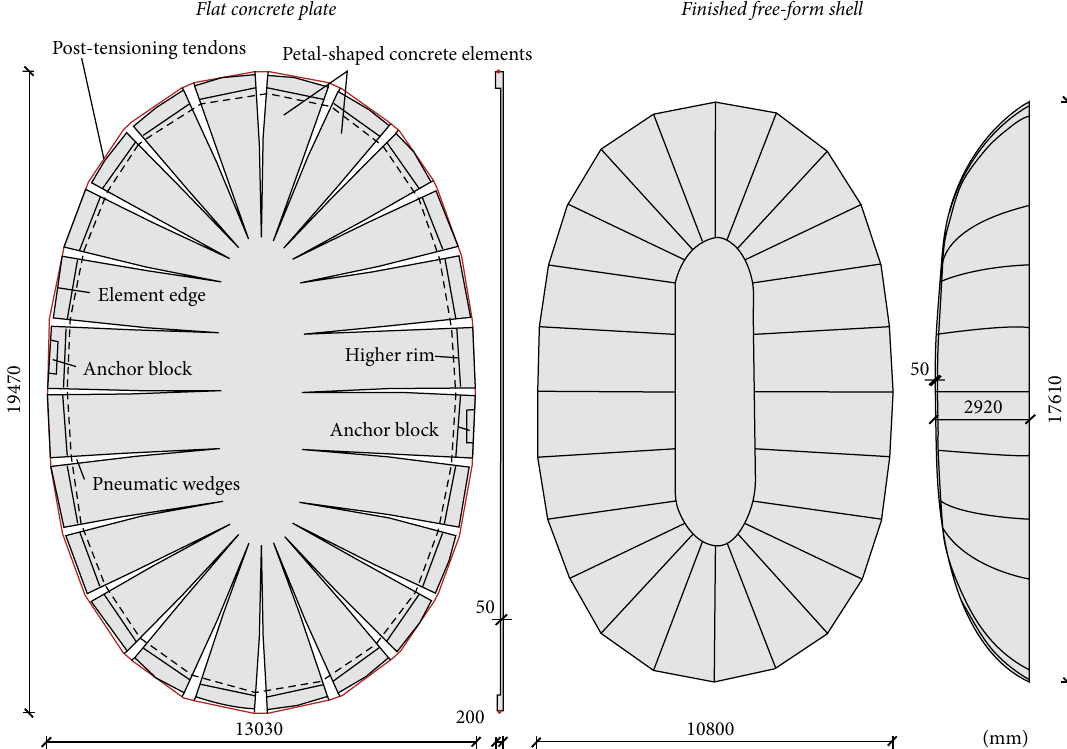
Figure 22: Dimensions for the erection of a free-form shell (large-scale